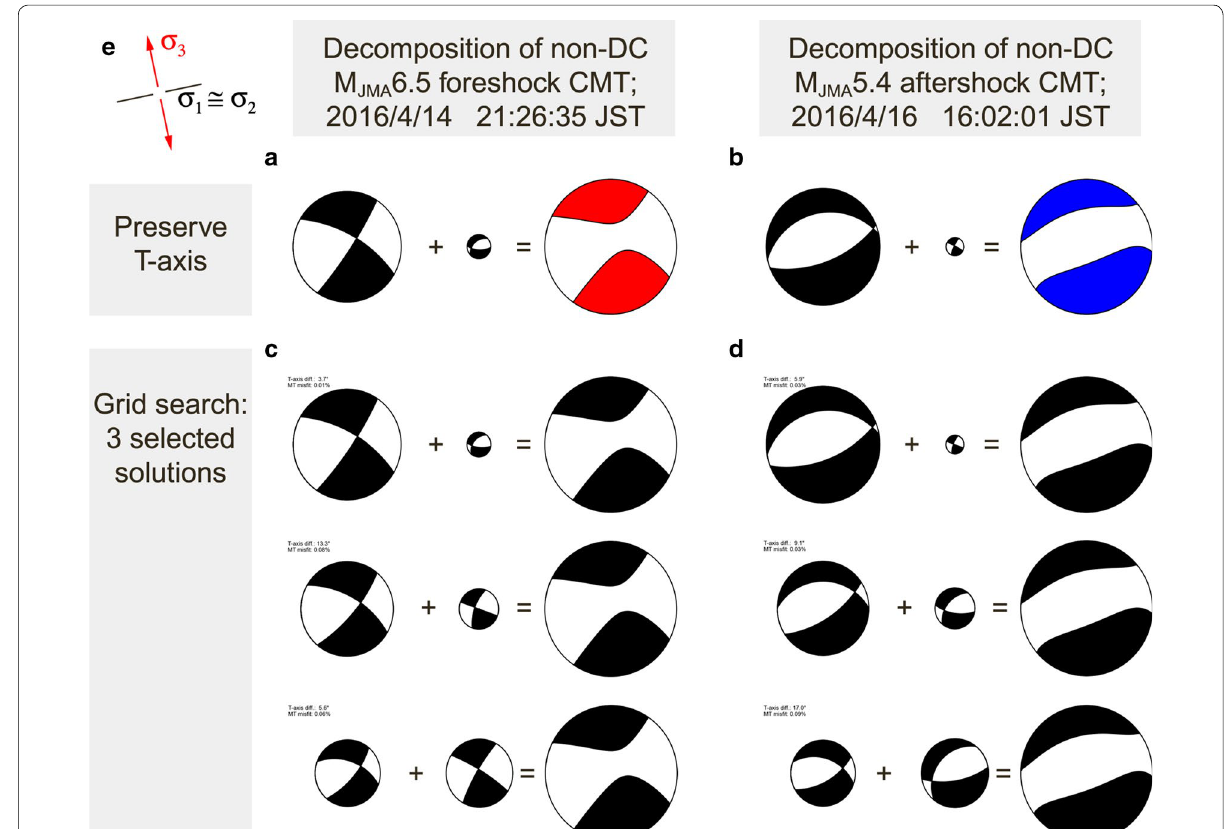
Fig. 7 Decomposition of non-DC MTs of the M JMA 6.5 foreshock (left column) and the M JMA 5.4 aftershock (right column) into combination of two DC MTs; DC MTs are shown together with their sum MT 1 + MT 2 = MT sum by trinity of beach-balls; radius of beach-balls is proportional to scalar seis- mic moment; a , b are unique solutions of the MT decomposition preserving main (T-)axis (Eqs. (13) and (14)); c , d are selected representative solu- tions of the non-unique MT decomposition by the grid search approach, where the scalar moments were obtained by a linear inversion (Eq. (15)); e the regional stress field indicated by directions of σ 1 , σ 2 and σ 3 . Adopted from Matsumoto et al.